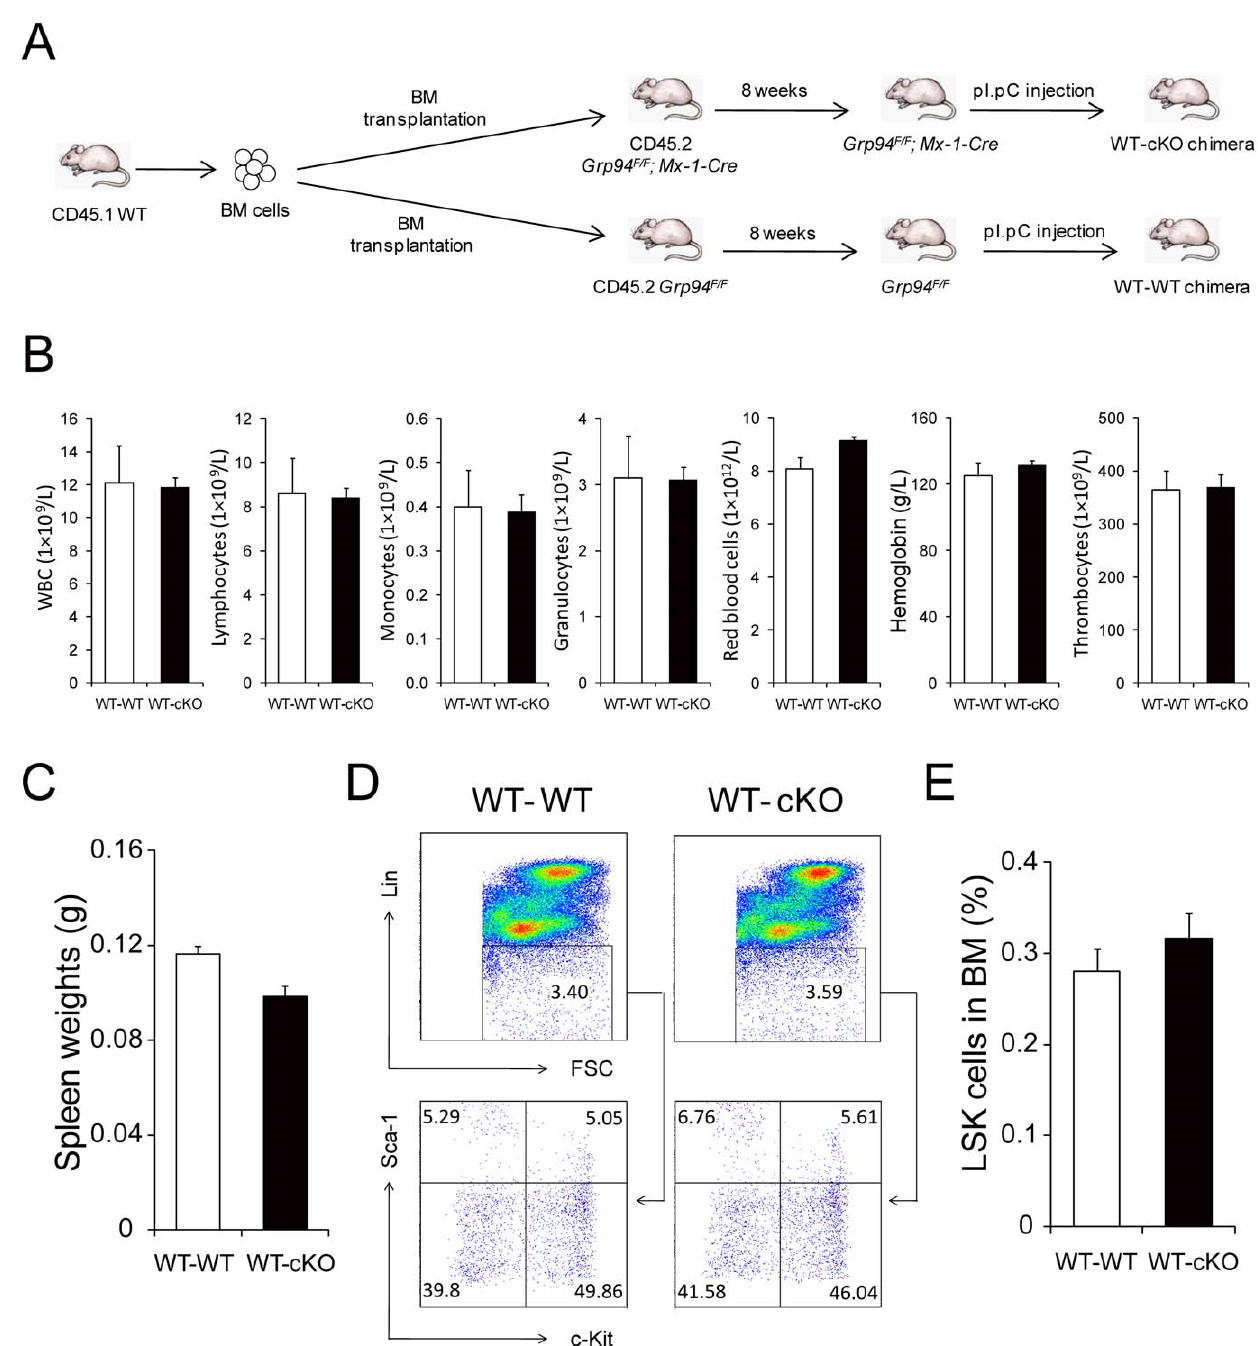
Figure 9. Effect of cKO microenvironment on HSC maintenance. A) Scheme of creating chimeric mice with WT hematopoietic cells transplanted into WT or cKO microenvironment. B) Complete blood count with tail peripheral blood from WT-WT (n=5) and WT-cKO (n=8) chimeric mice. C) Quantitation of spleen weights from WT-WT (n=4) and WT-cKO (n=5) chimeric mice. D) Representative flow cytometric analysis with BM from WT-WT and WT-cKO chimeric mice using Lin, c-Kit and Sca-1. E) Summary of percentage of LSK cells in the BM from WT-WT (n=5) and WT-cKO (n=8) chimeric mice. All data are presented as mean 6 s.e..